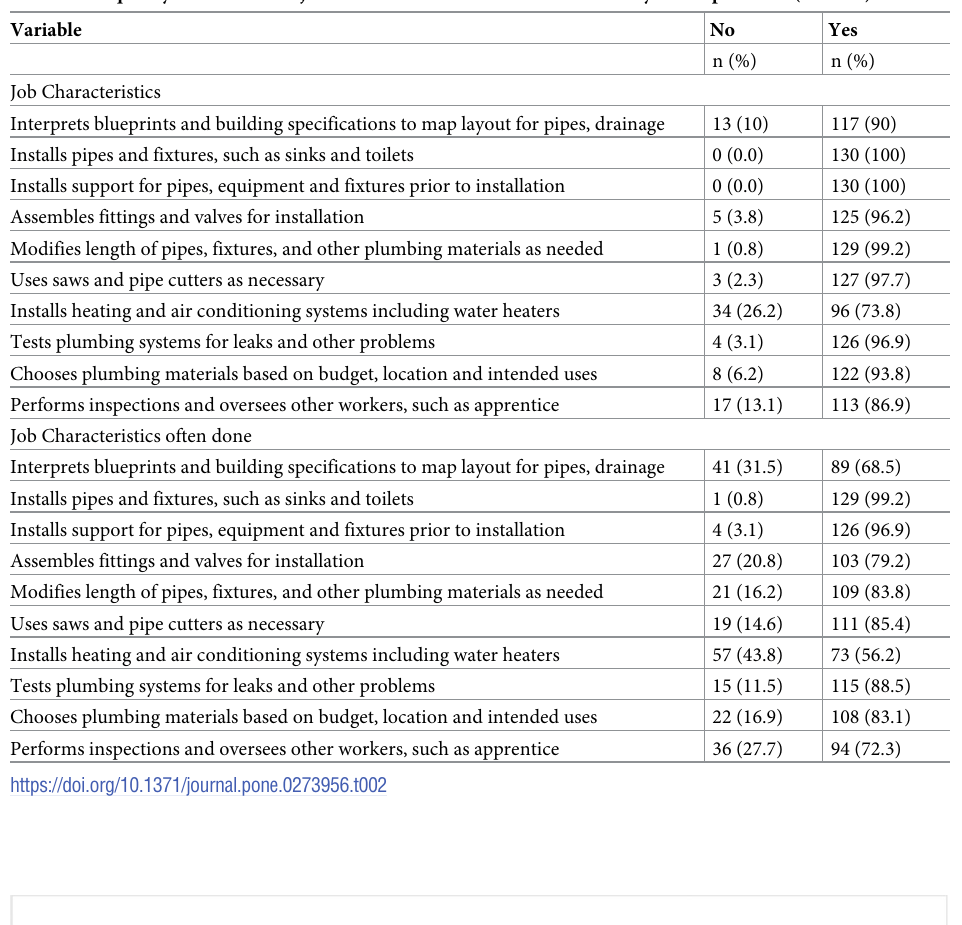
Table 2. Frequency distribution of job characteristics and those often done by the respondents (N = 130).